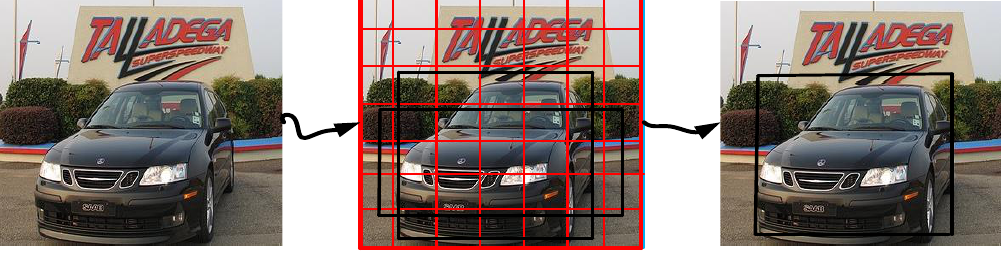
Figure 3. Detection principle. Figure 3. Detection